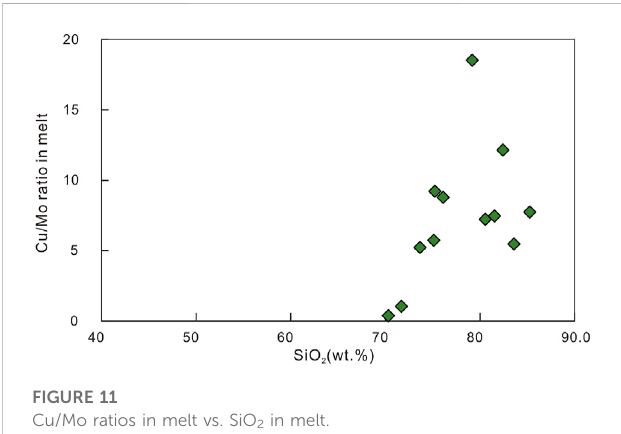
FIGURE 11 Cu/Mo ratios in melt vs. SiO 2 in